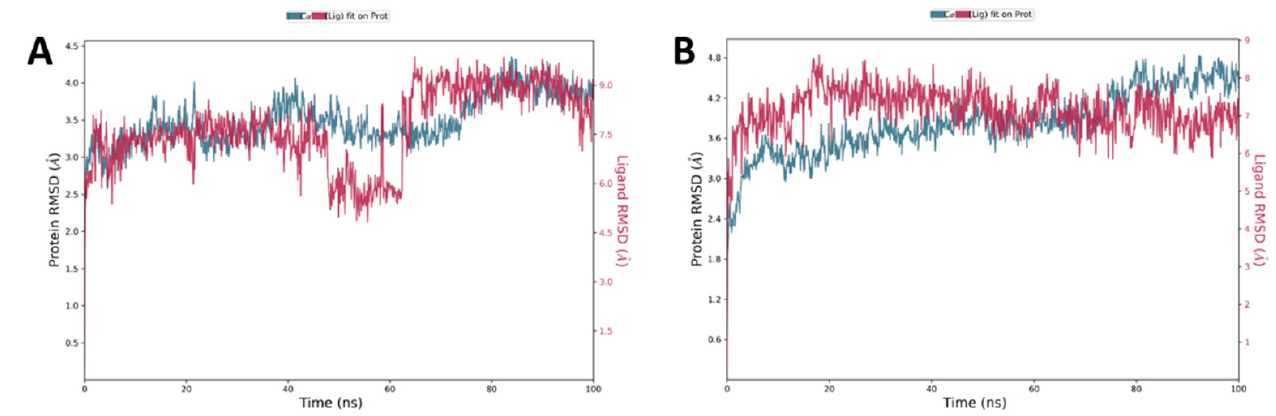
Figure 10. Time-dependent root mean square deviation (RMSD) (Å) for 7 ( A ) and 8 ( B ) during the 100 ns molecular dynamics simulation.